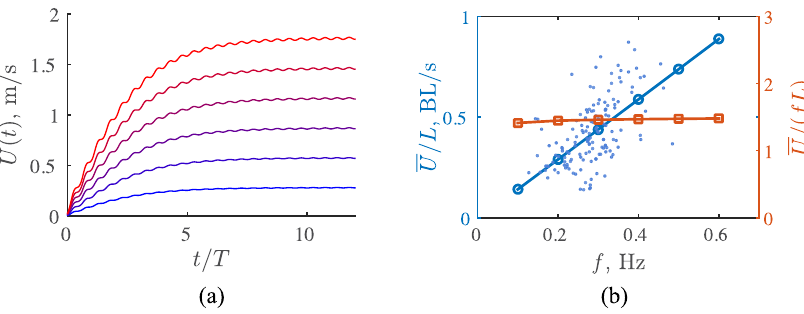
Figure 11. ( a ) Time-varying swimming speed for manta rays swimming at six different frequencies. From blue to red the oscillation frequency is increasing by increments of 0.1 Hz from 0.1 to 0.6 Hz; ( b ) Cycle-averaged speed at as a function of frequency (left axis). Also, on the left axis is the biological data from Figure 7a marked by the blue points. On the right axis the cycle-averaged speed is normalized by fL.